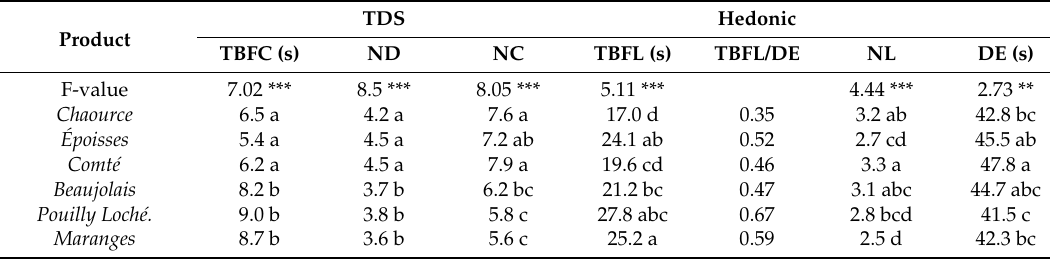
Table 4. Mean values for: Time Before the First Citation (TBFC), Number of Descriptors used (ND), total Number of Clicks used (NC), Time Before the First Liking rating (TBFL), proportion of TBFL in relation to the total Duration of the Evaluation (TBFL/DE), the number of ratings given for the hedonic test (Number of Liking ratings (NL)) and total Duration of the Evaluation (DE) for wines and cheeses evaluated in mono-intake